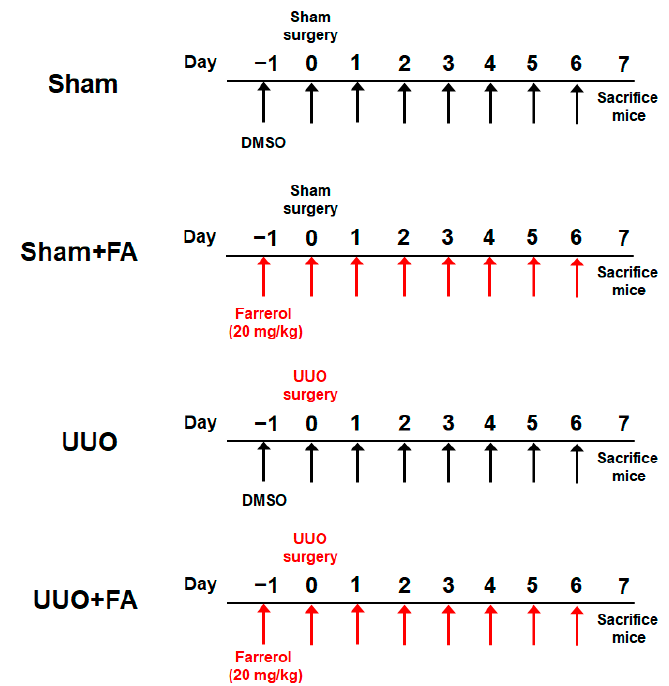
Figure 1. Overview of the animal experiment